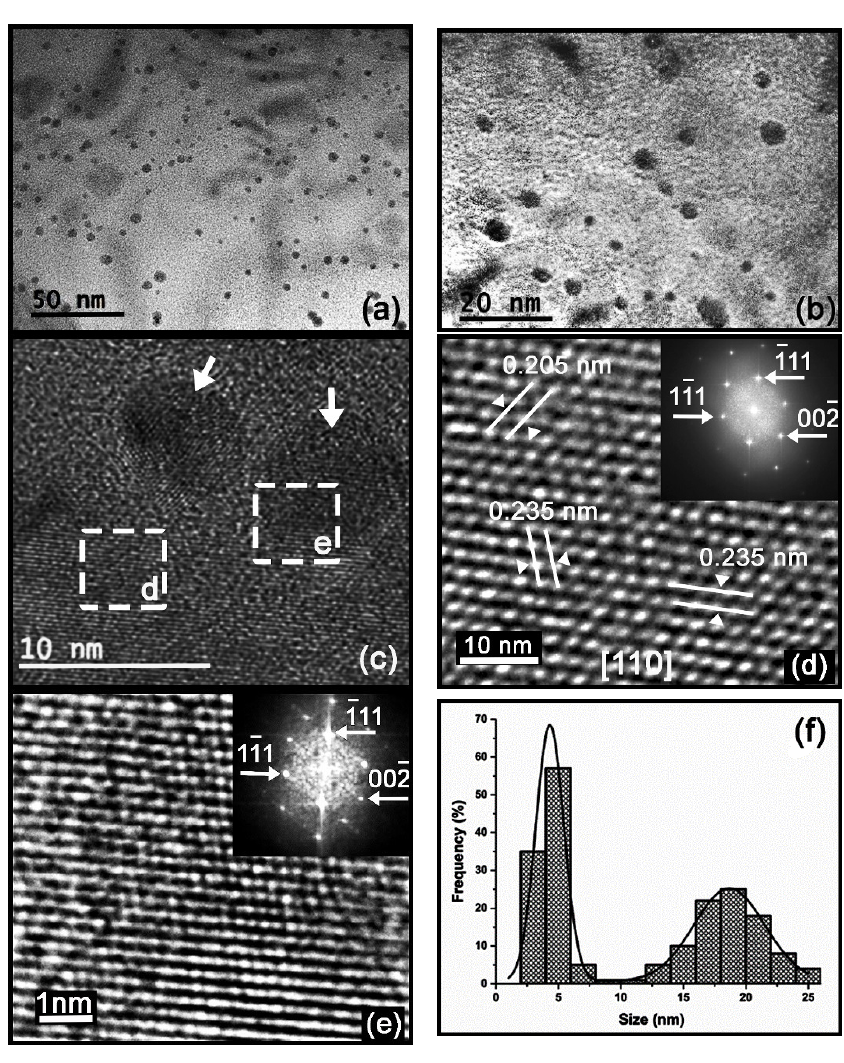
Figure 5. Alloy-II aged at 400 °C for 425 h. ( a , b ) TEM images at different magnifications showing the size and morphology of the precipitates; ( c ) TEM image showing two nanometric precipitates; ( d ) HRTEM image of the area enclosed by the dashed square “d” in ( c ) in which the solid white lines show the measured interplanar distances; the inset in this image shows the indexed FFT pattern; ( e ) HRTEM image (including its indexed FFT pattern) of the area enclosed by the dashed square “e” in ( c ) showing the coherence of a nanometric precipitate of the metastable L1 2 -Al 3 Zr phase with the lattice of α(Al) matrix in the (110) plane; ( f ) Histogram of the size distribution of the precipitates.